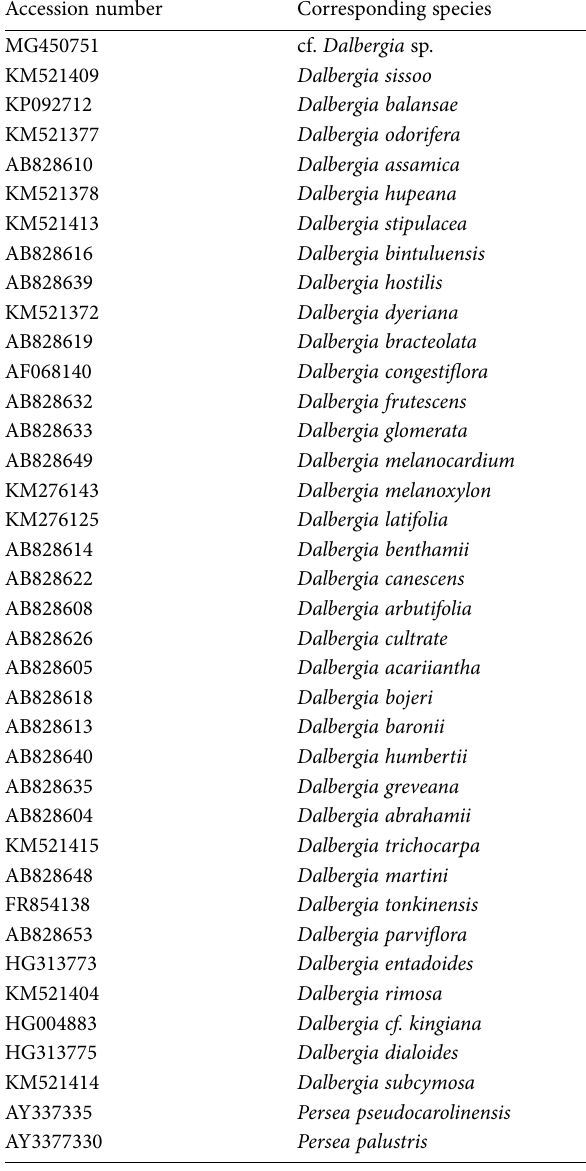
Table 2. The thirty-eight species used for constructing the phyloge- netic tree for cf. Dalbergia sp. with their accession